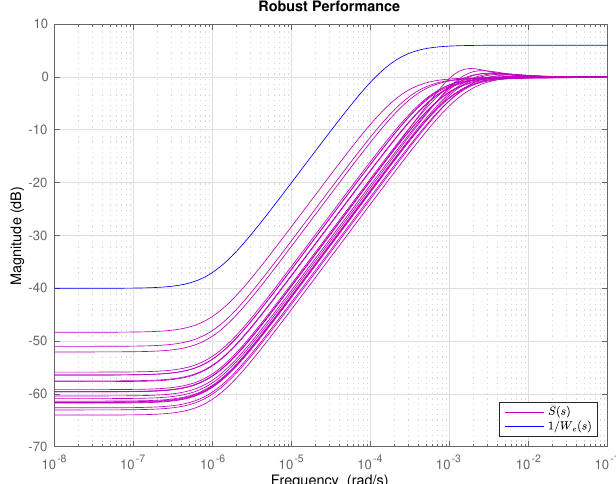
Figure 15. Aproximated robust performance analysis for the reduced order controller, ¯ C ( s )